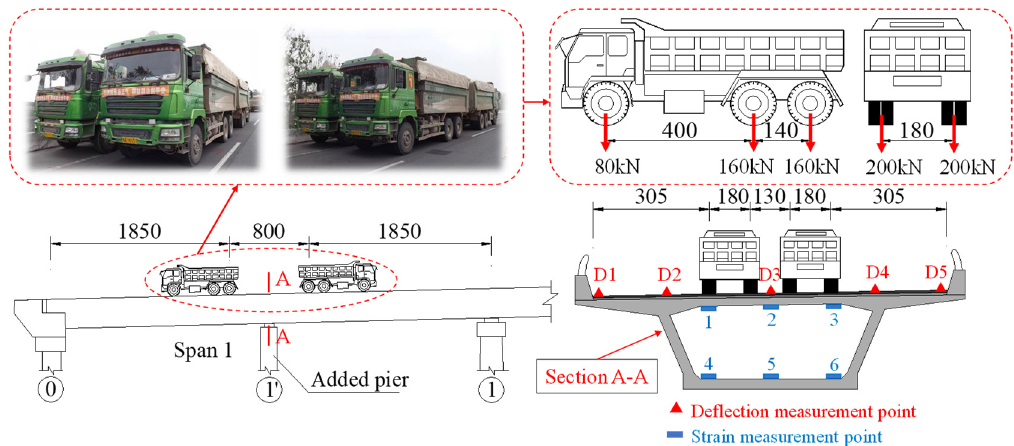
Figure 10. Loading test truck and measuring point arrangement (unit: cm). Table 6. The girder deflection and strain test results.